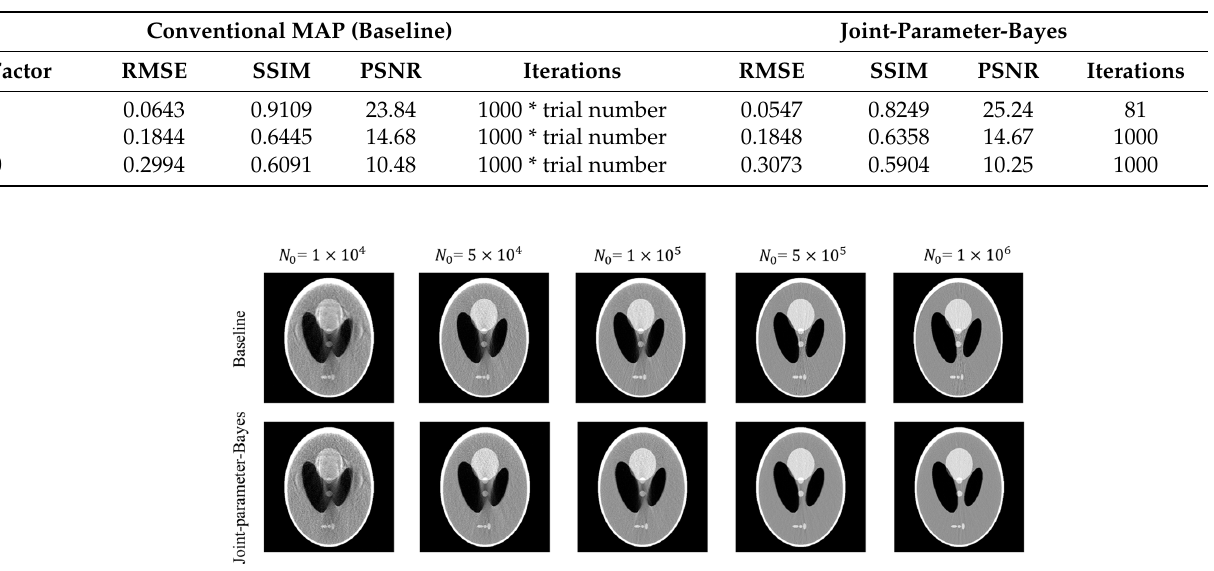
Figure A1. Comparison of reconstructed images between the conventional MAP (baseline) and joint-parameter-Bayes with Poisson noise to post-log sinogram data. Table A1. Quantitative comparison of joint-parameter-Bayes with conventional MAP (baseline) with Poisson noise to post-log sinogram data.